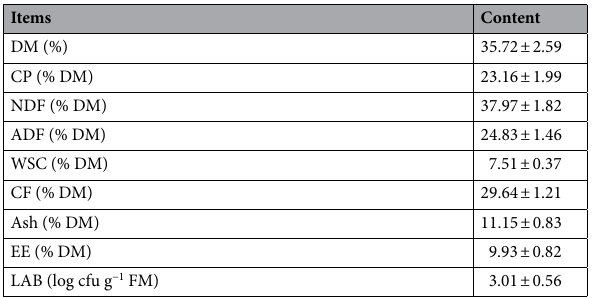
Table 2. Chemical and microbial compositions after alfalfa wilting. DM dry matter, CP crud protein, NDF neutral detergent fiber, ADF acid detergent fiber, WSC water soluble carbohydrates, CF crud fiber, Ash crud ash, EE ether extract, LAB lactic acid bacteria, cfu colony-forming units, FM fresh